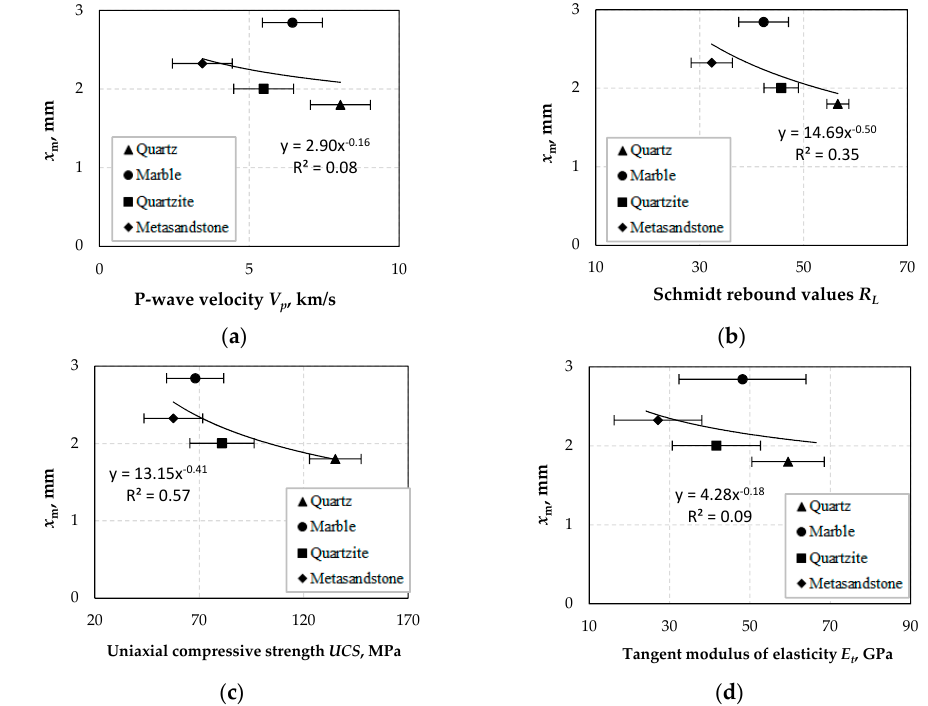
Figure 14. Correlations between optimum size x m and ( a ) P-wave velocity V p , ( b ) Schmidt rebound values R L , ( c ) uniaxial compressive strength UCS and ( d ) tangent modulus of elasticity E t ; horizontal error bars show standard deviation of the measurements.